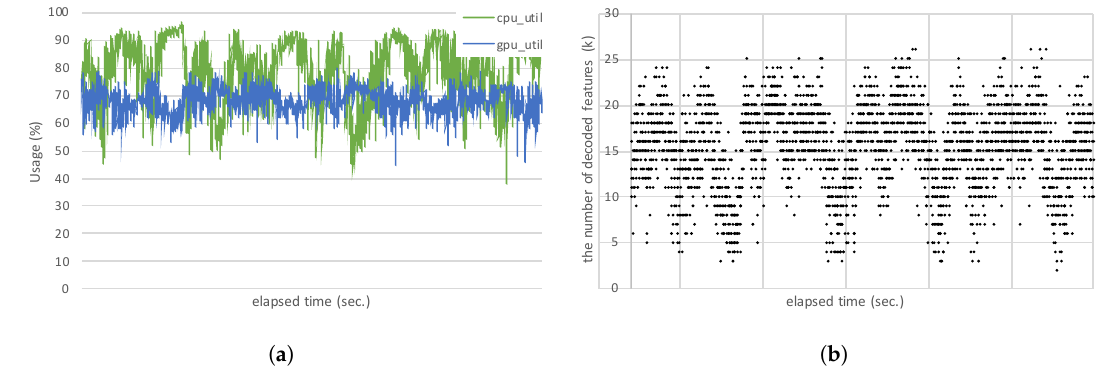
Figure 6. Performances of an ASR system using the proposed fast parallel acoustic score computation method of BLSTM AM with the test set, in terms of ( a ) CPU and GPU usages (%) and ( b ) the number ( k ) of parallel decoded feature vectors of the proposed method for each acoustic score computation time. The green and blue lines indicate the CPU and GPU usages, respectively. Table 8. Comparison of SyllER (%) and the multichannel performance of the Korean online ASR systems using the proposed acoustic score computation method of BLSTM AM with/without the frame skip technique on search space expansion during Viterbi decoding, with the set set. SyllER (%) Max. Clients proposed decoding